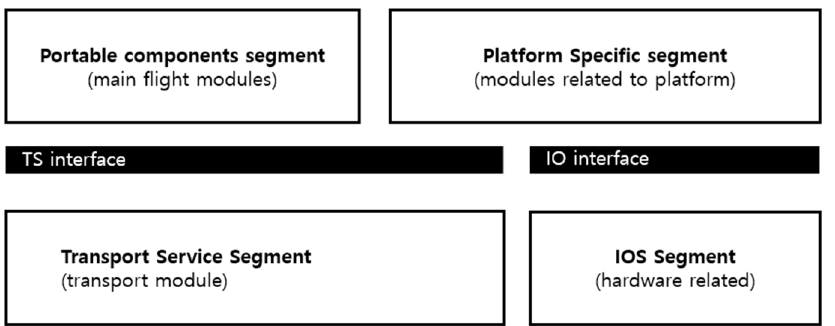
Figure 3. The overall design of the FACE architecture.